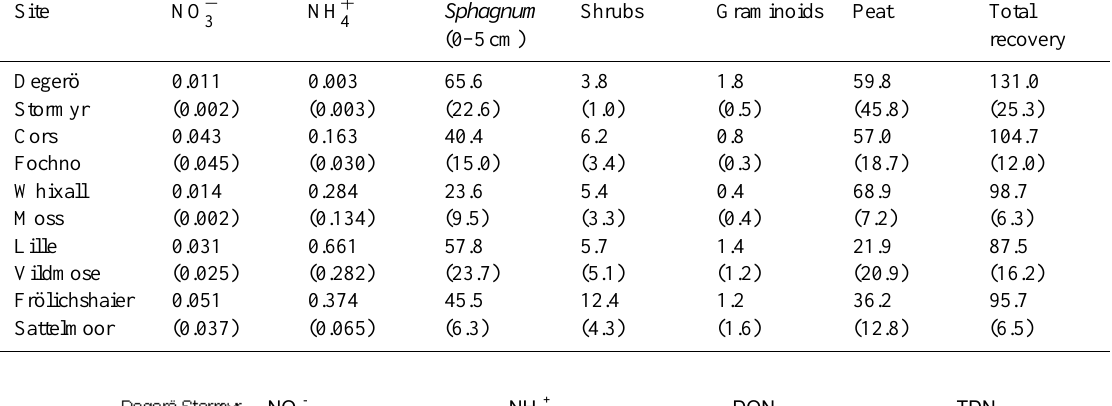
Table 2. Recovery of 15 N (%) for all sites and percent contribution of N ecosystem pools to the total recovery at each site after 24 weeks of tracer application. NO − and NH + were analyzed in peat pore water. Standard deviations are given in parentheses. 3 4